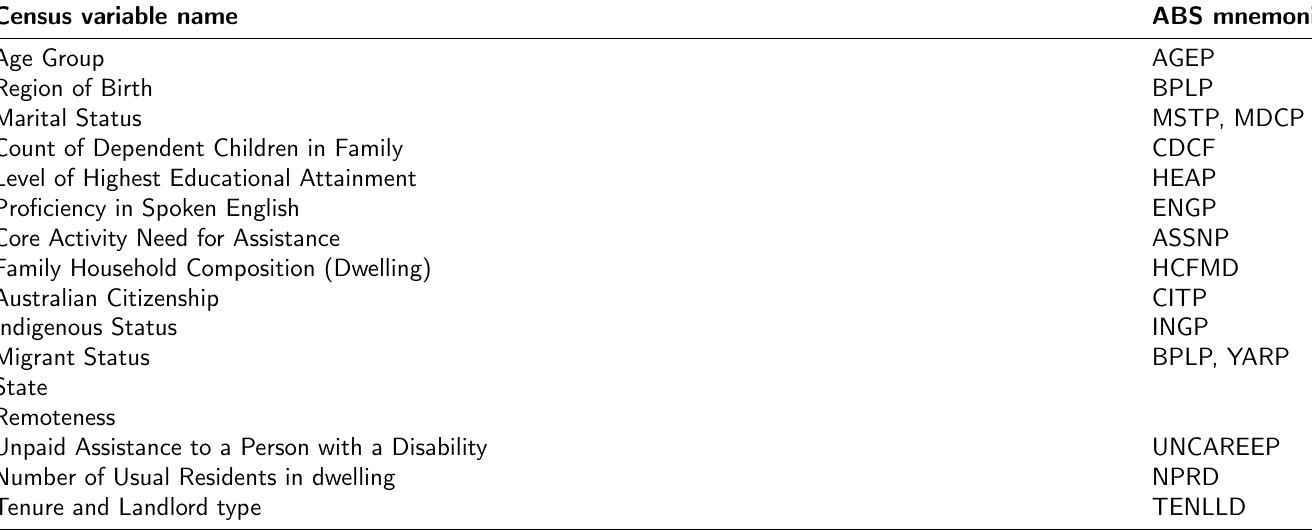
Table 1: Census variables included as population